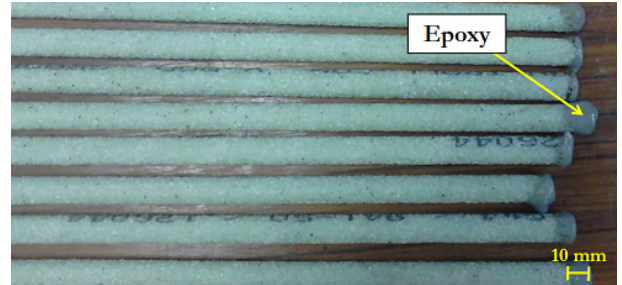
Figure 1. Rebars intended for direct immersion in the alkaline solution.